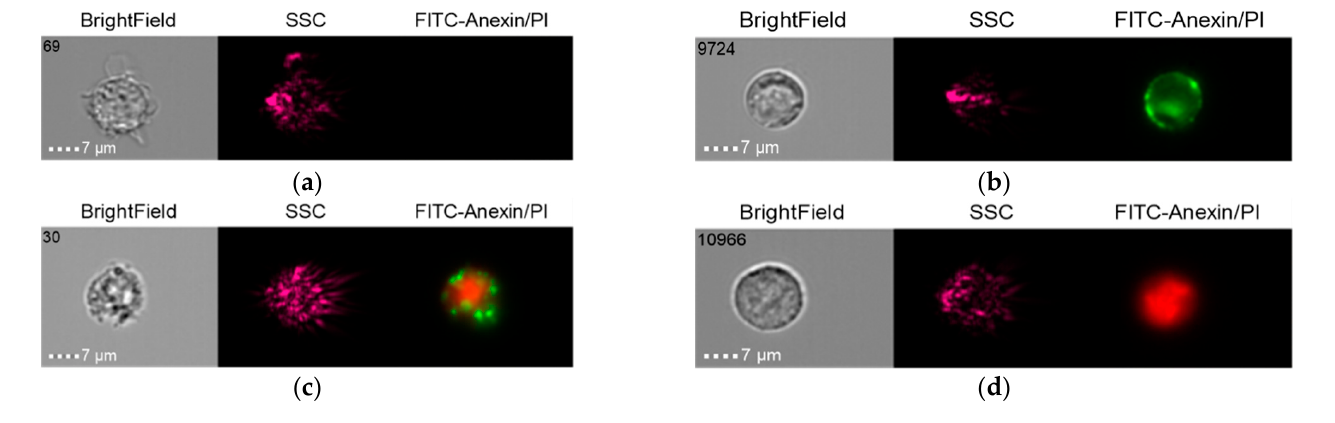
Figure 10. Live cells ( a ), early apoptosis ( b ), late apoptosis ( c ), necrosis ( d ) after co-culture of Alpha Bio NSMP with THP-1 cell line (Alpha Bio NSMP + DSP + THP-1).